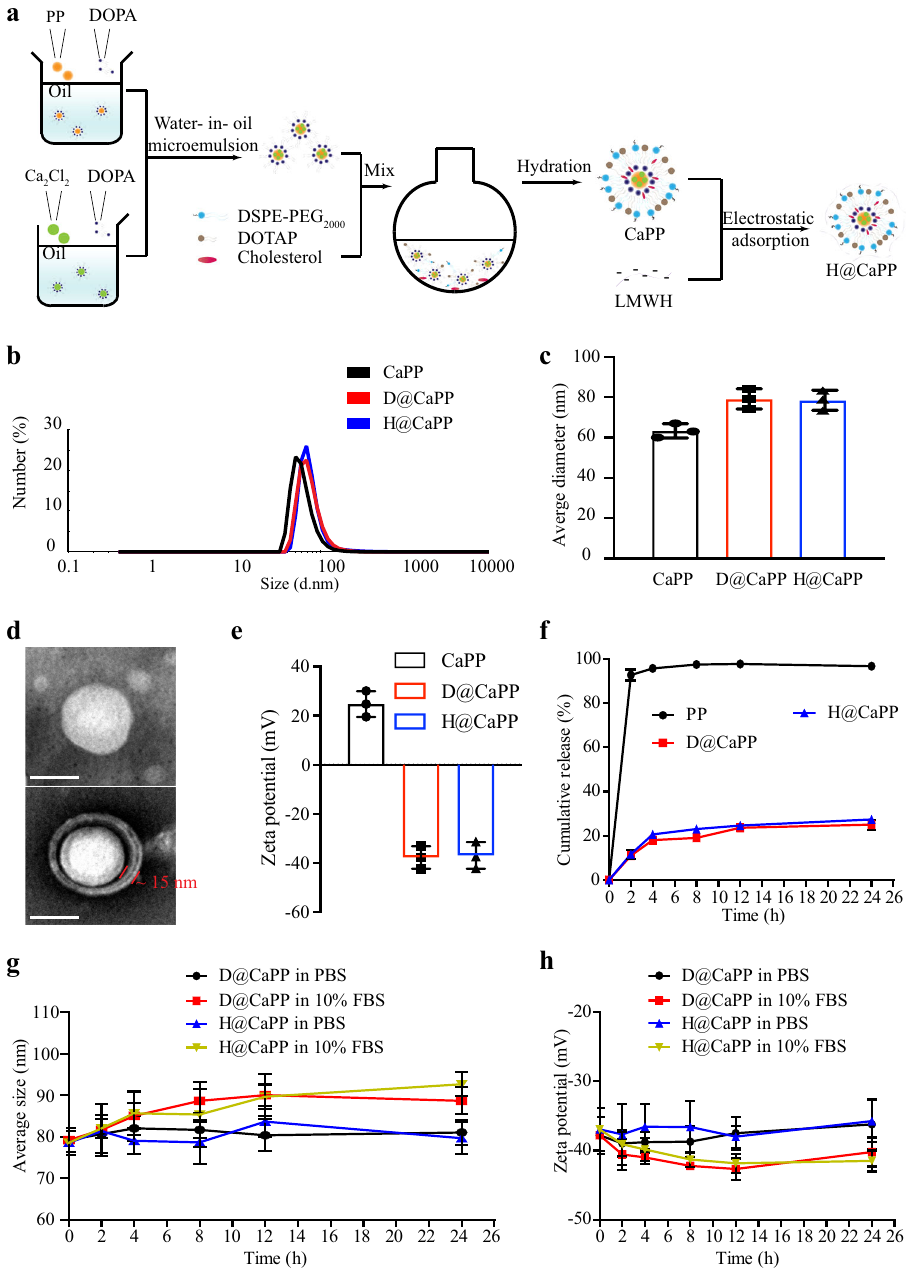
Fig. 2 Preparation and characterization of H@CaPP. a Schematic illustration of the preparation route of H@CaPP. b Particle size of CaPP, D@CaPP, and H@CaPP measured by dynamic light scattering. c Average diameter of CaPP, D@CaPP, and H@CaPP (mean ± SD, n = 3 samples per group). d Morphology of CaPP and H@CaPP. Scale bar, 50 nm. The experiments were repeated three times independently. e Surface zeta potential of CaPP, D@CaPP, and H@CaPP (mean ± SD, n = 3 samples per group). f The PP release pro fi le of D@CaPP, H@CaPP, or PP in PBS (pH 7.4) at 37 °C with gentle stirring (mean ± SD, n = 3 samples per group). g Average size of D@CaPP and H@CaPP within 24 h incubation with 10% FBS or PBS (pH 7.4) at 37 °C, respectively. h Zeta potential of D@CaPP and H@CaPP incubated with 10% FBS or PBS (pH 7.4) at 37 °C, respectively within 24 h (mean ± SD, n = 3 samples per group). Error bars represent